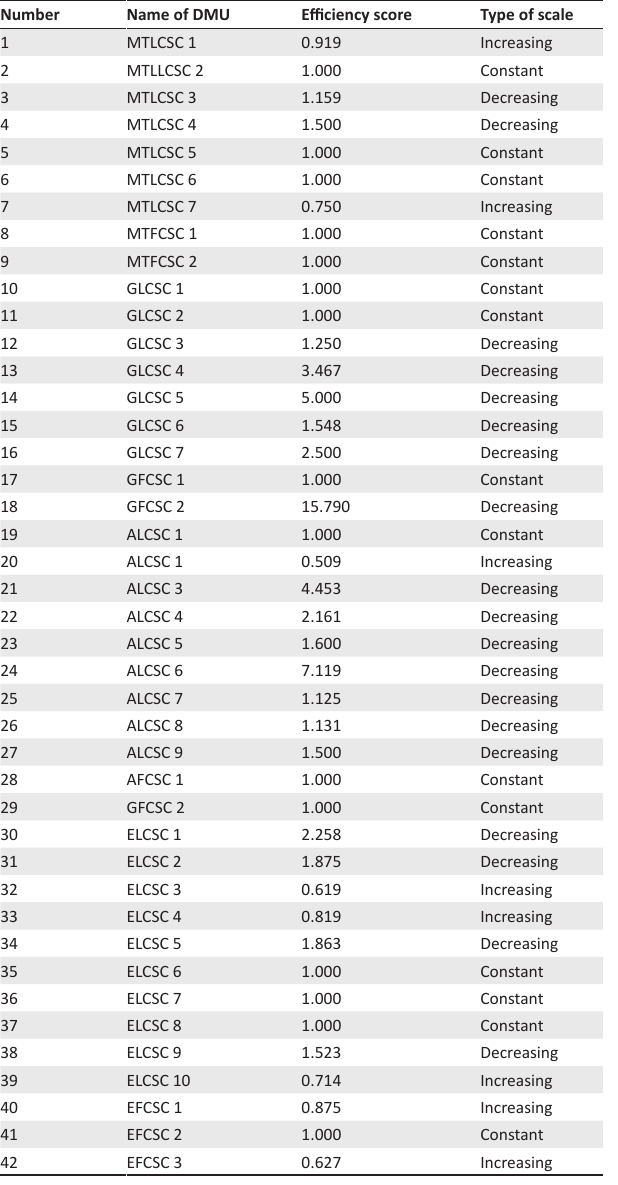
TABLE 1-A1: Results of output-oriented constant returns to scale model: Pure technical efficiency – CSC in Lagos state and